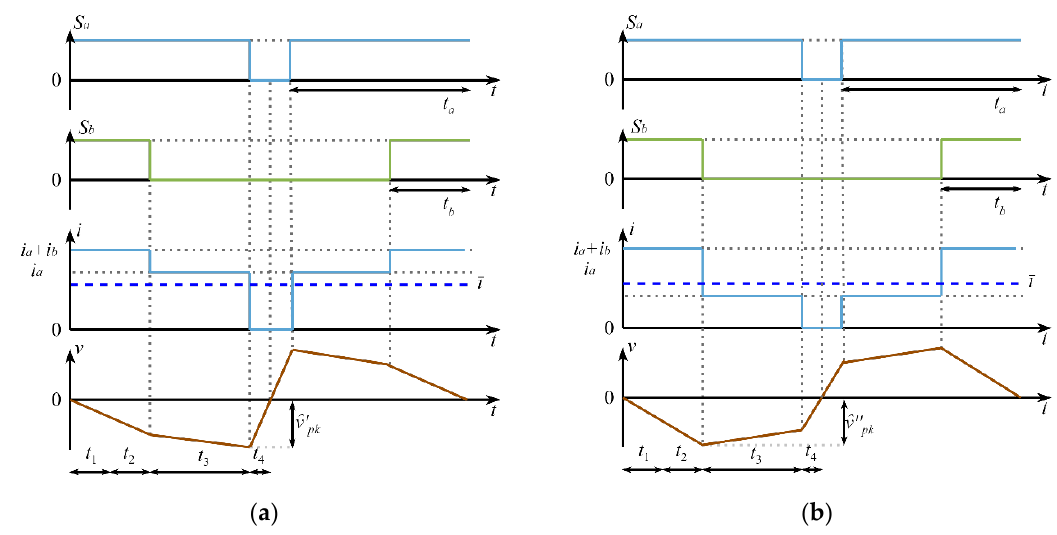
Figure 8. Input current and voltage ripple in one switching period in case of an unbalanced load (only two phases). ( a ) i a ≥ ī ( b ) i a < ī .